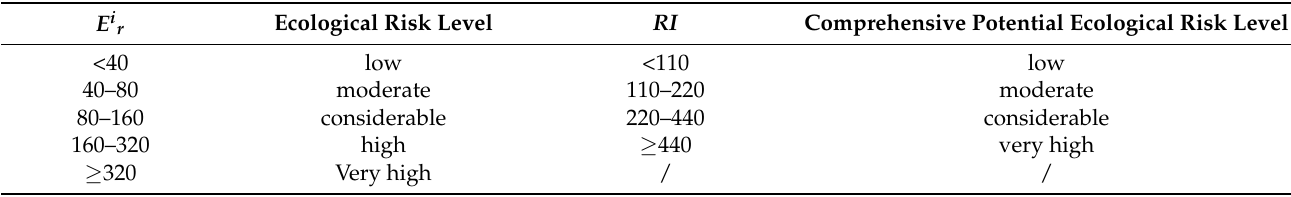
Table 4. Ecological risk index and grades of risk intensity. /: